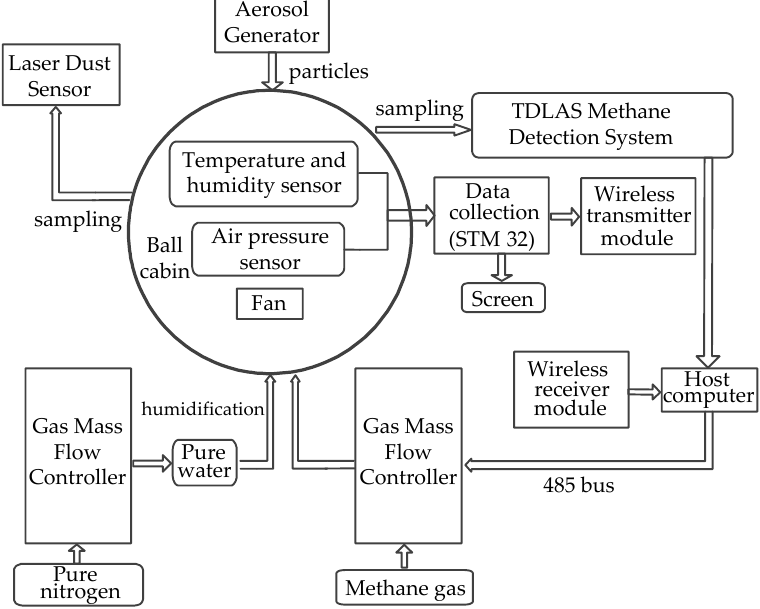
Figure 2. Block diagram of the methane-concentration measurement and control